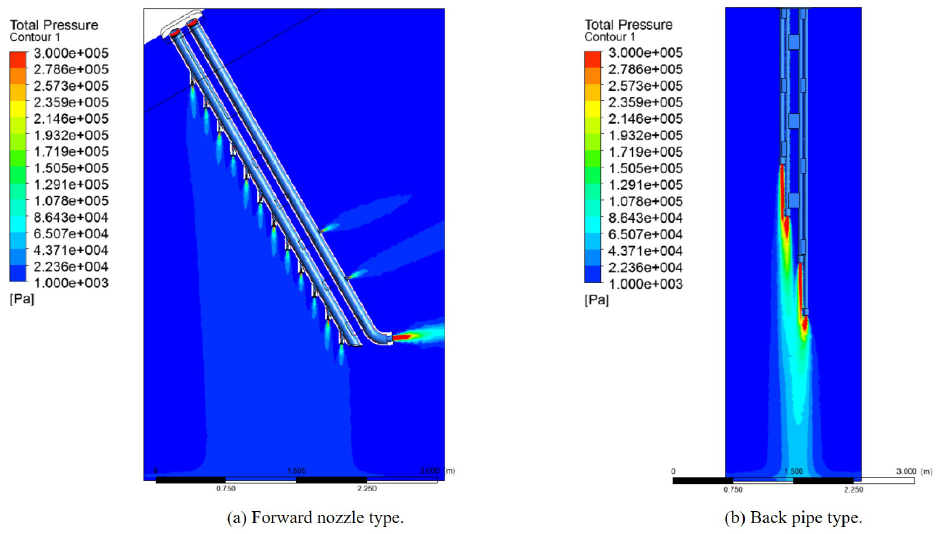
Figure 1. CFD simulation test with two types of jetting